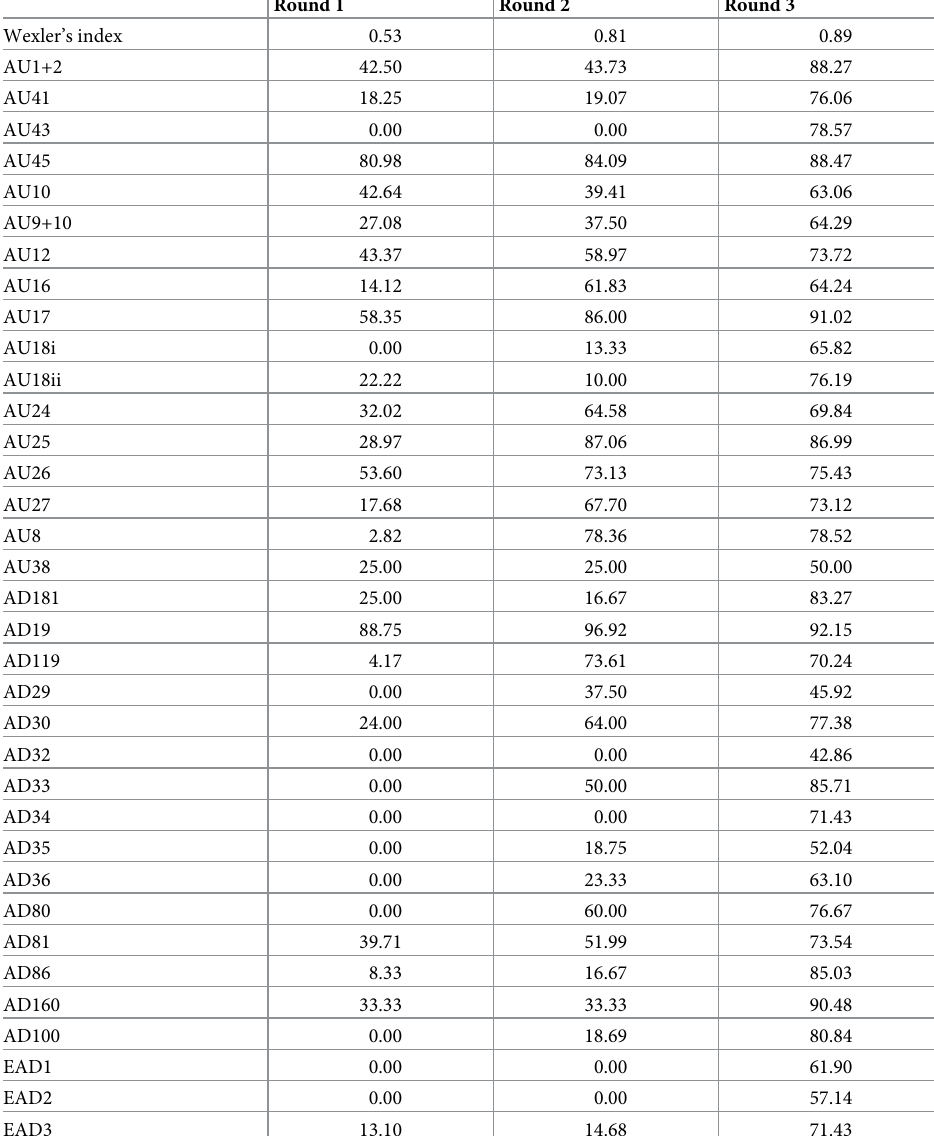
Table 1. Wexler’s index (1972) and independent coding agreement for each AU, AD and EAD in three coding